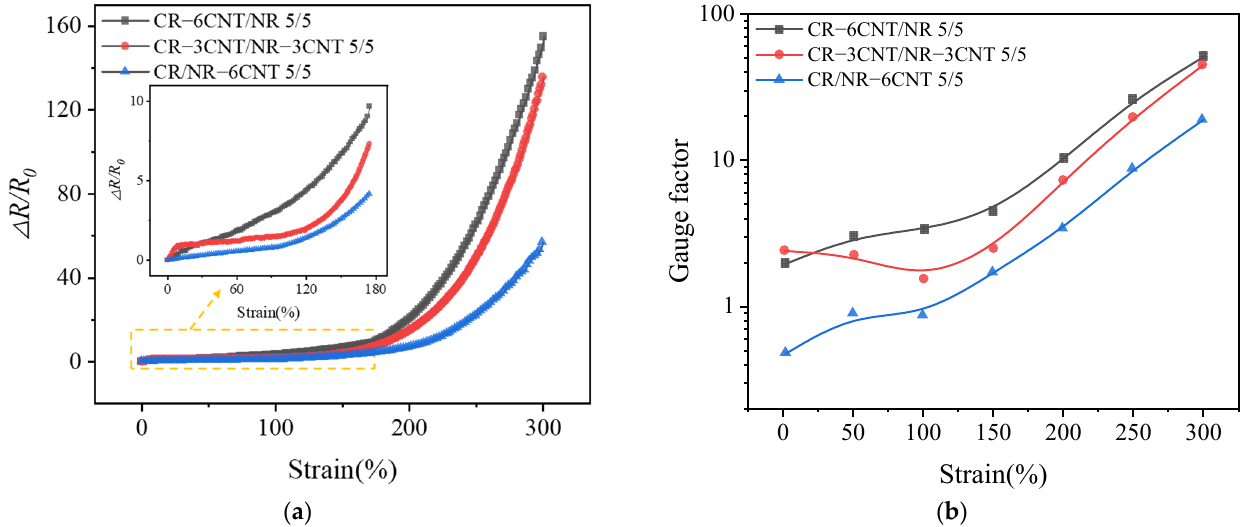
Figure 6. The relationship between ∆ R / R 0 ( a ) and gauge factor ( b ) and applied strain for composite materials.